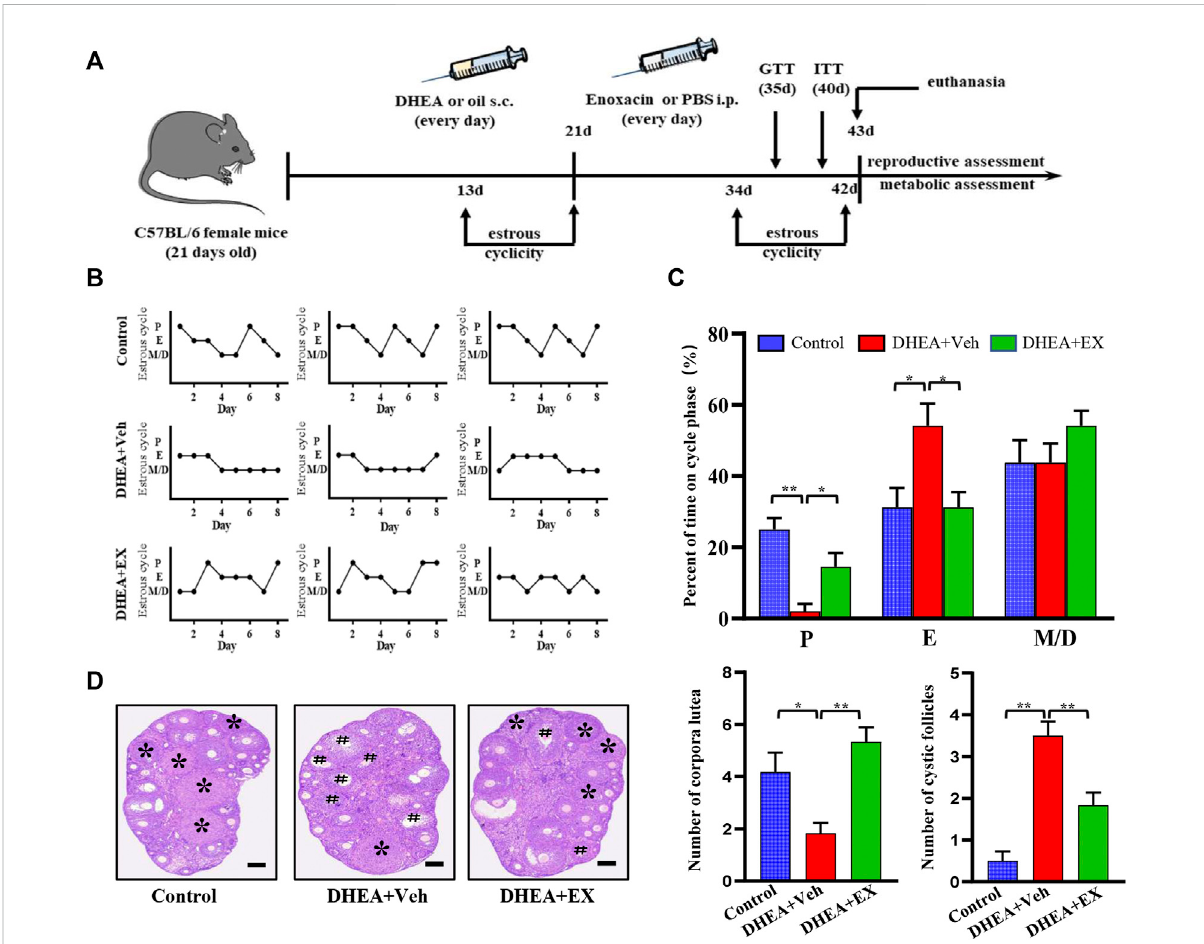
FIGURE 1 Enoxacin treatment ameliorated irregular estrous cyclicity in DHEA-induced PCOS upon chow diet. (A) Schematic of animal experiment process; (B,C) The estrous cycle of mice under chow diet conditions; (D) H&E staining of representative ovaries. The cystic follicle is indicated by a hashtag, while the corpora lutea are indicated by asterisks. Scale bar: 200 μ m. Values are represented as the mean ± SE. n = 5 – 6. P values were determined by one-way ANOVA with Tukey ’ s multiple comparison post-hoc test. * p < 0.05, ** p < 0.01. DHEA, dehydroepiandrosterone; Veh, vehicle; EX,